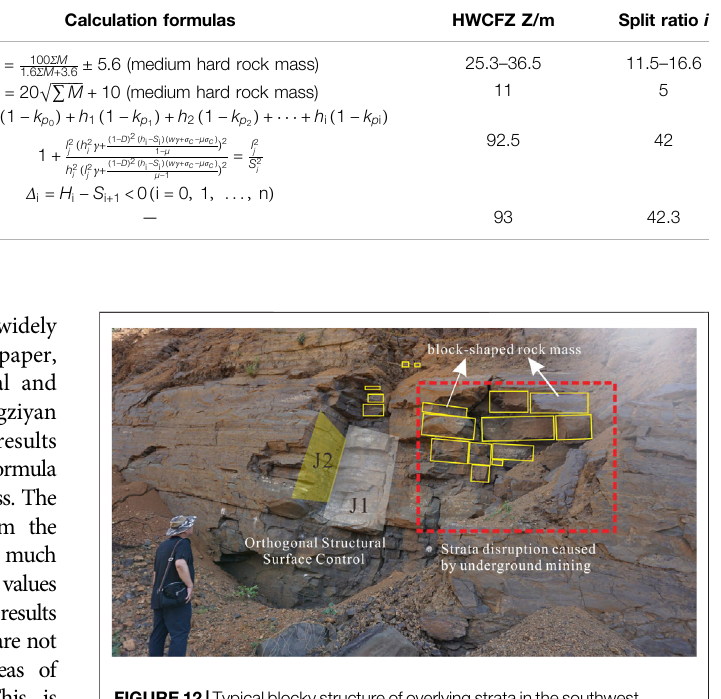
TABLE 5 | Comparison of calculation results between the empirical formulas, theoretical formulas, and numerical simulations.